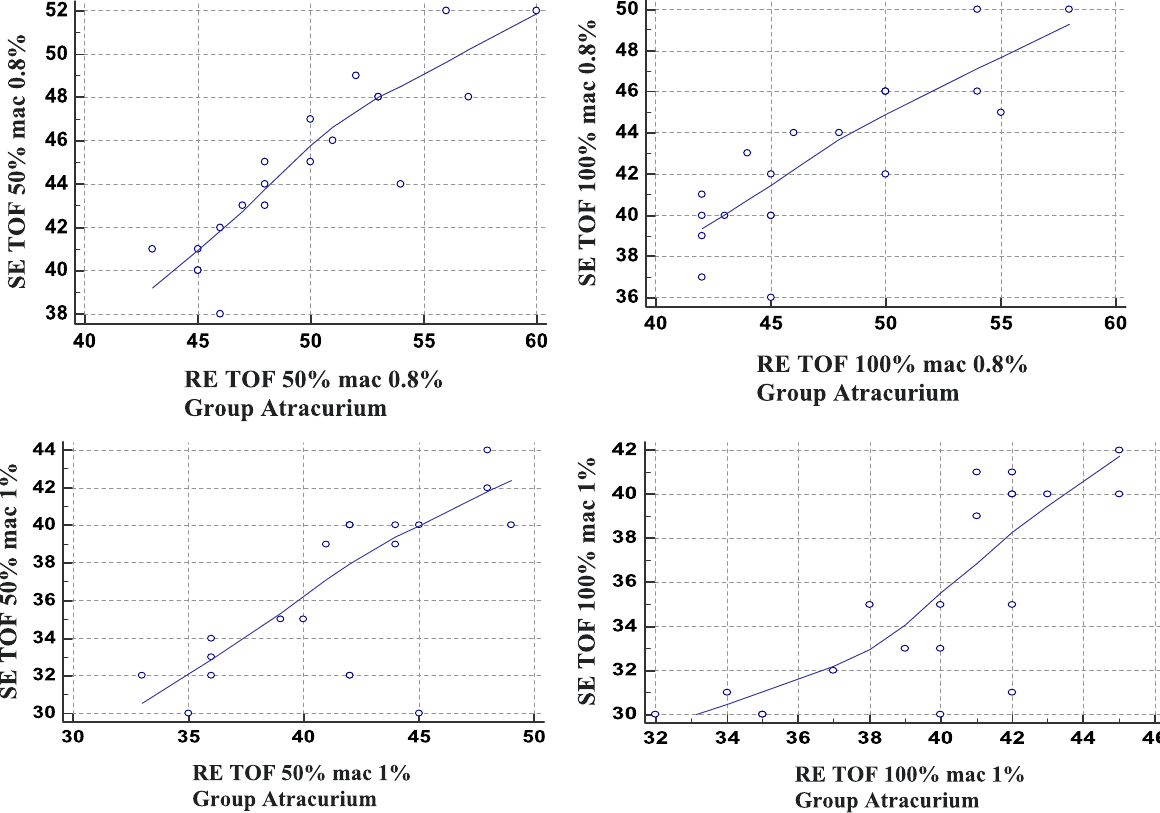
Fig. 2 Correlations between RE and SE at MAC 0.8% and 1% with TOF 50% and 100% of atracurium